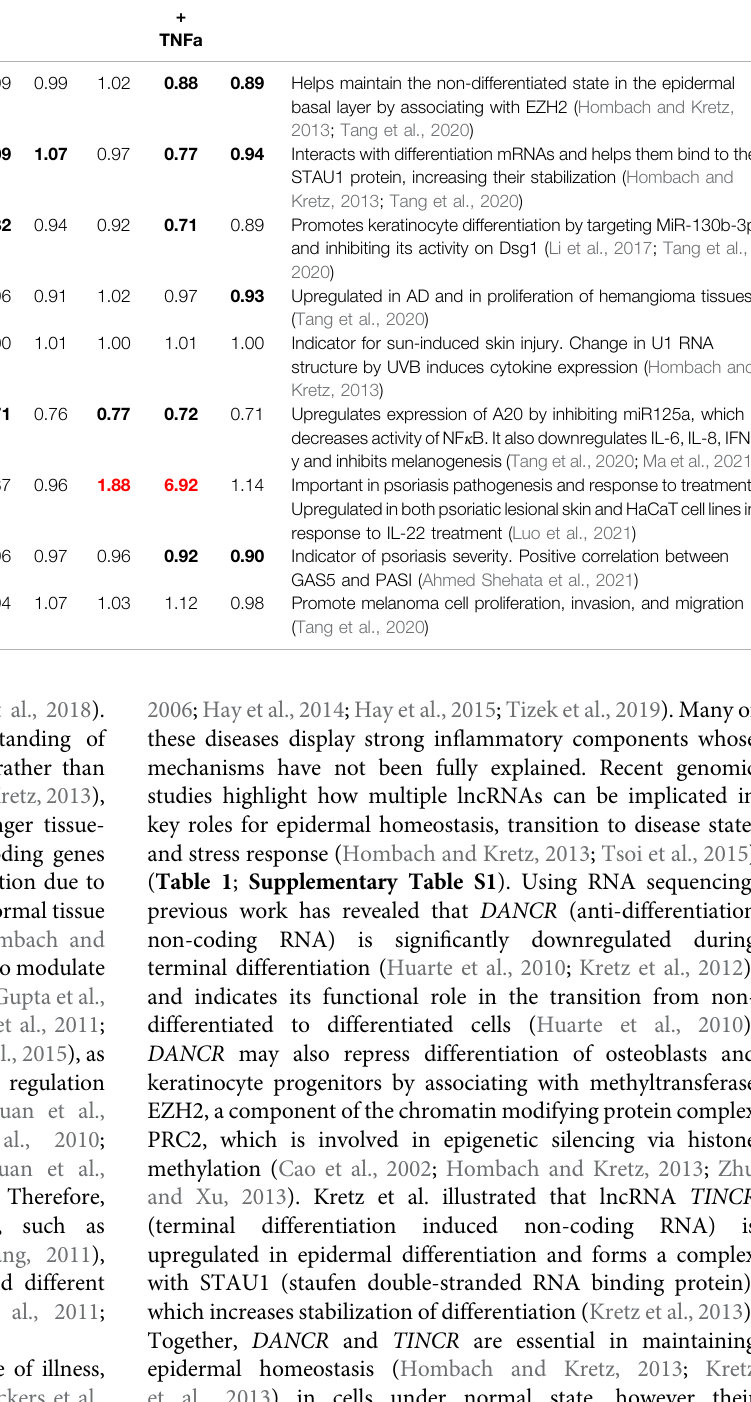
TABLE 1 | The fold change for the notable lncRNAs that play roles in skin biology and/or diseases. Bold numbers denote FDR ≤ 0.05. Red results denote at least 1.5-fold change when comparing against control/unstimulated conditions. Expression in in fl ammatory skin disease represents fi ndings in lesional skin of atopic dermatitis/ psoriasis patients compared to control without skin